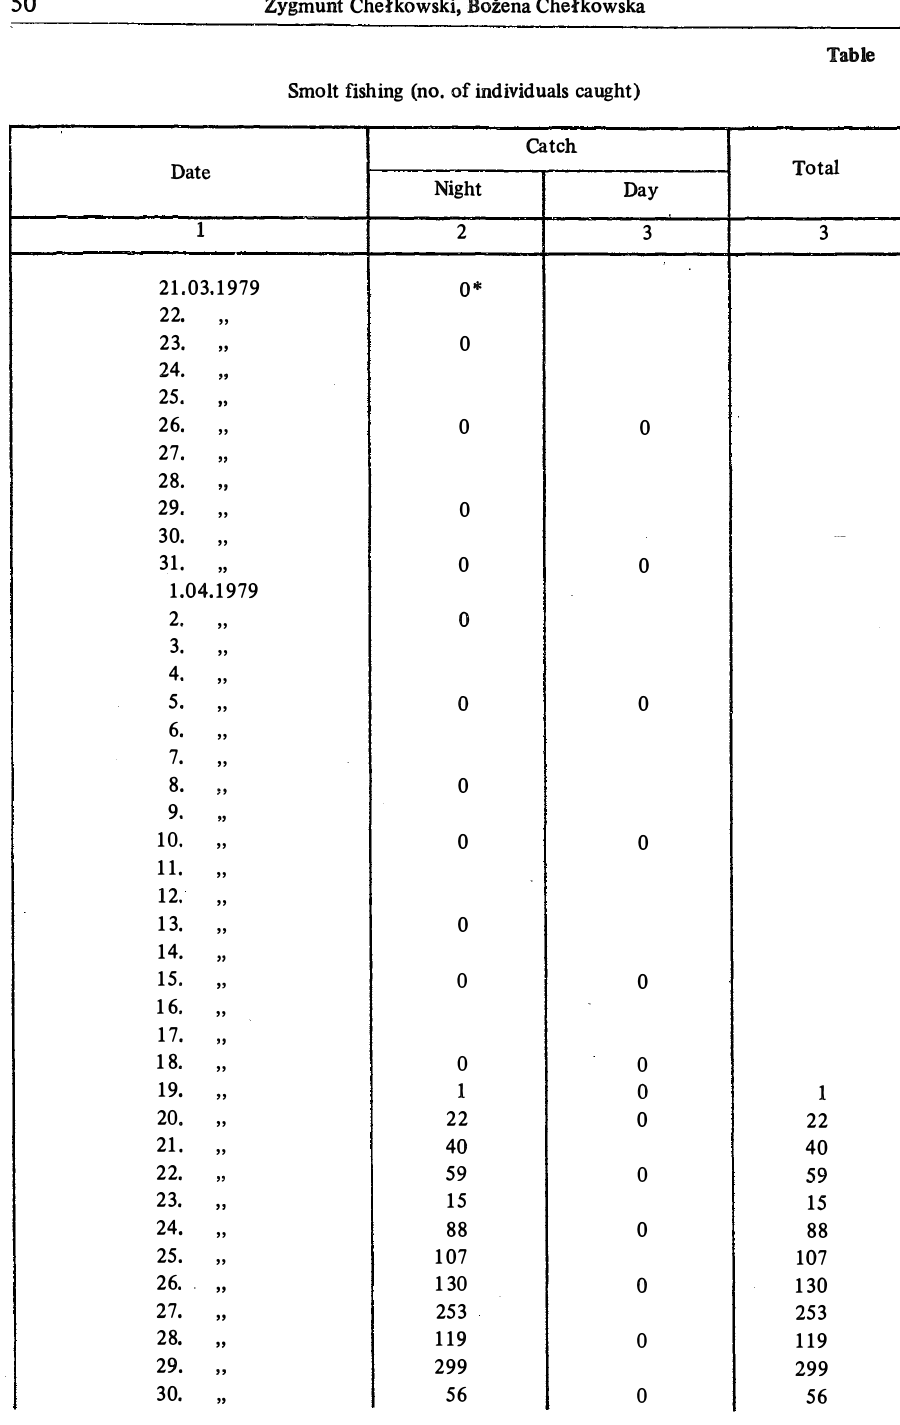
Smolt fishing (no. of individuals